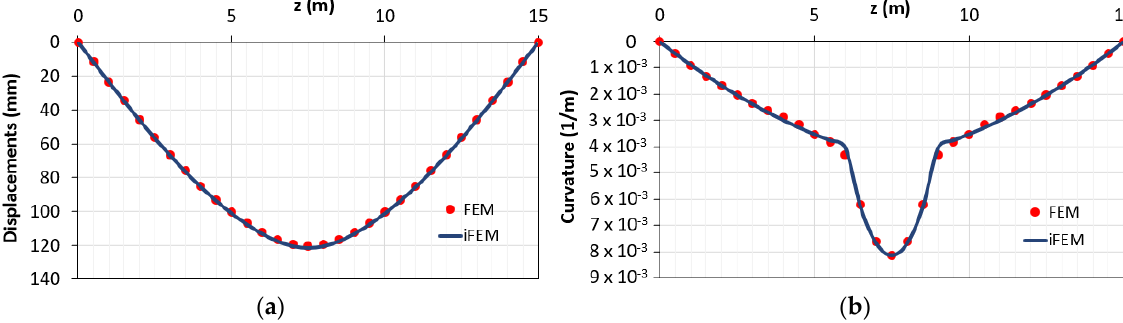
Figure 14. Output in case of the estimate of the central element length: ( a ) displacements diagram; ( b ) curvature diagram.